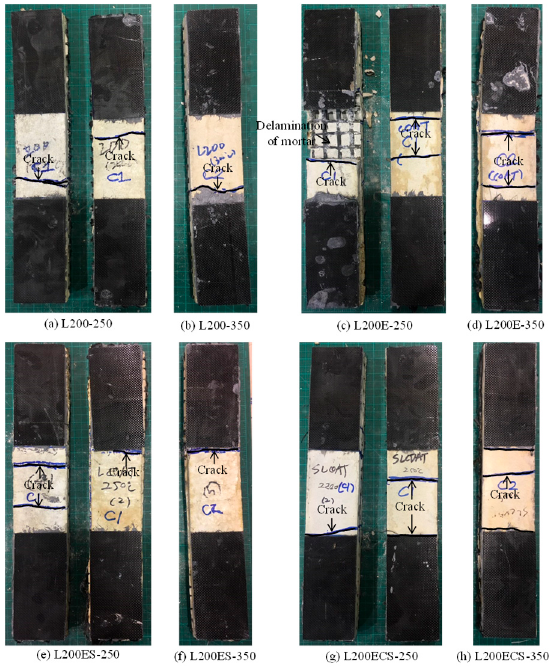
Figure 10. Failure modes of TRM test specimens in the third series.